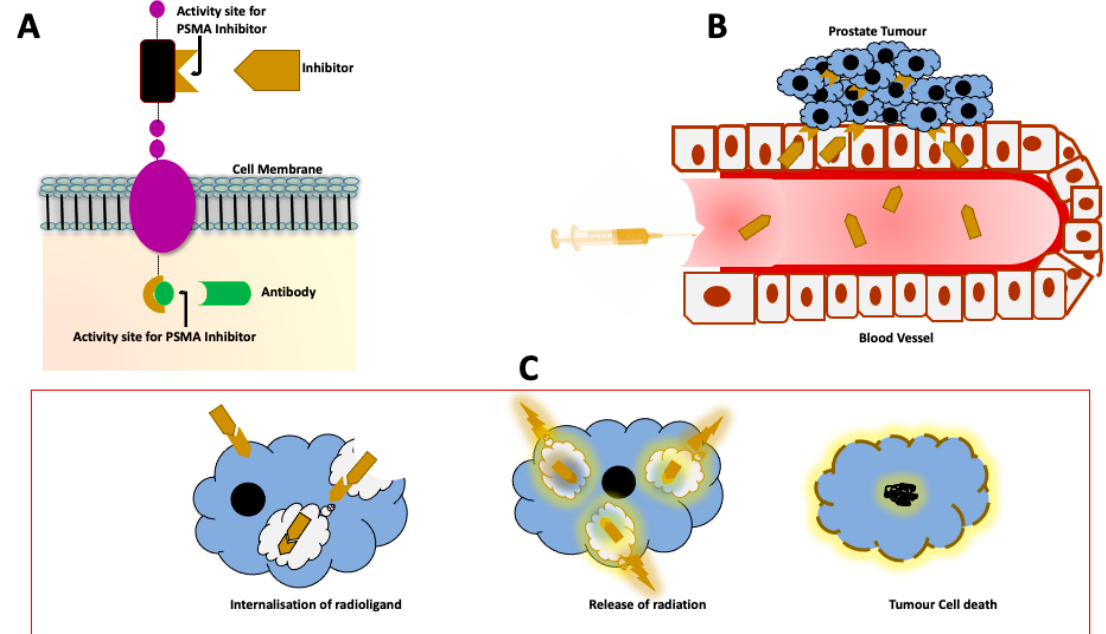
Figure 1. Illustration of theragnostic approach to the management of PCa. ( A ) The PSMA protein with the different components, namely the intracellular, transmembrane and the extracellular portion. The activity sites on both the intracellular and extracellular domains have been used for binding of monoclonal antibodies, minibodies and small molecules. This enables targeting of the PSMA protein for both imaging and therapy. ( B ) Once the tracer is injected into the bloodstream, the PSMA ligand binds to the activity site on the tumour cells. ( C ) After binding to the activity site on the cell membrane, the radioligand is internalized and releases radiation from within the cell. The end product is DNA damage with resultant tumour cell death.